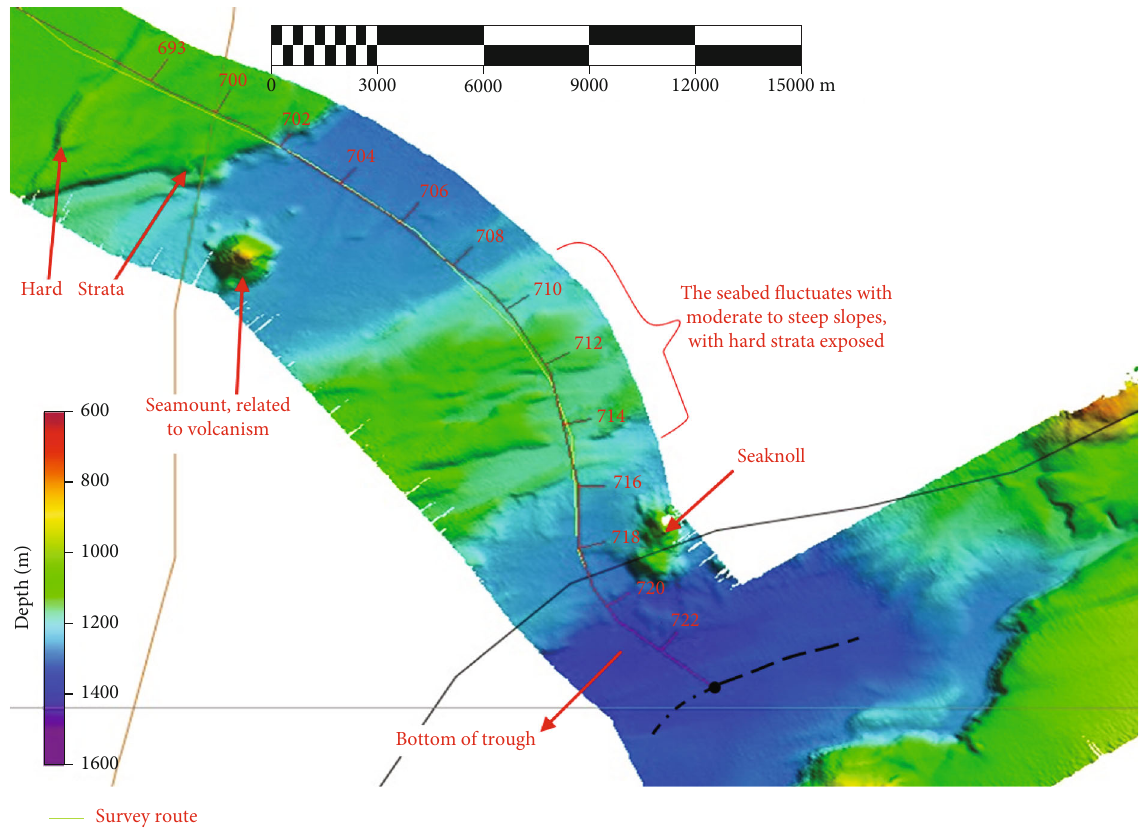
Figure 20: Typical Okinawa Trough gullies and abyssal hills/seamounts interspersed as revealed by multibeam.